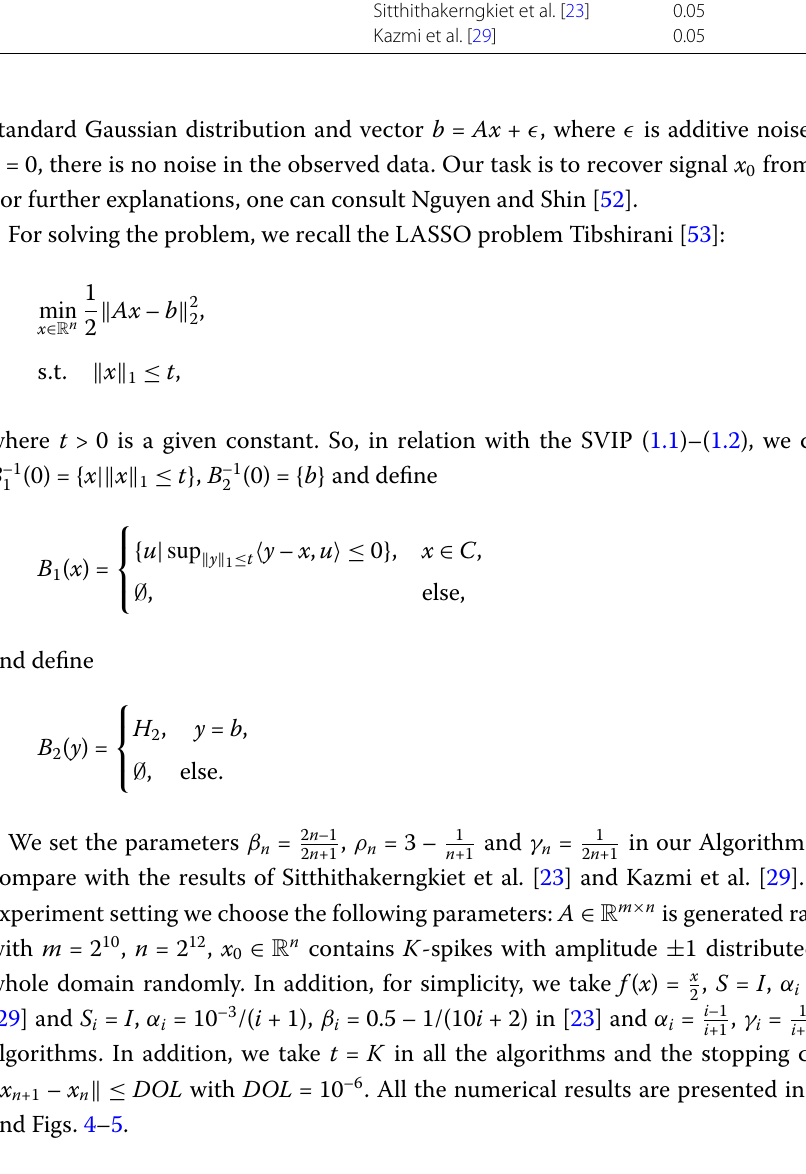
Table 4 Comparison of Algorithm 3.2 with those of Sitthithakerngkiet et al. [23] and Kazmi et al. [29] K , m and n DOL Method Step size Iter ( n ) K = 50, m = 2 10 , n = 2 12 10 –6 Algorithm 3.2 λ n Algorithm 3.2 Algorithm 3.2 λ